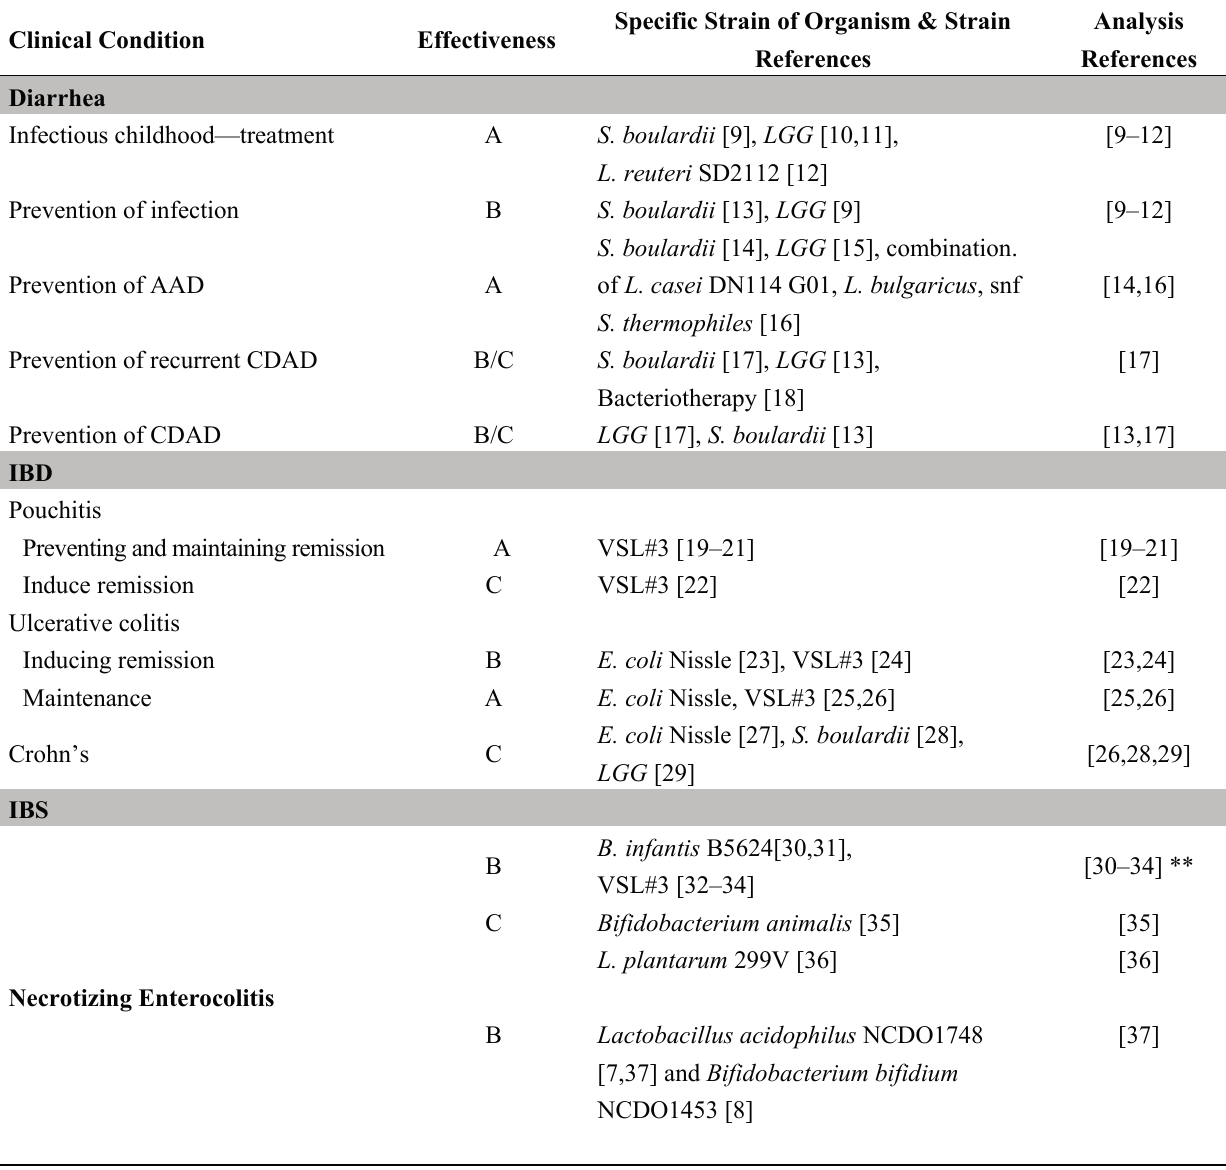
Table 1. Recommendations for Probiotic Use—Update 2011. Data from [5]. Copyright (2011) Lippincott Williams &